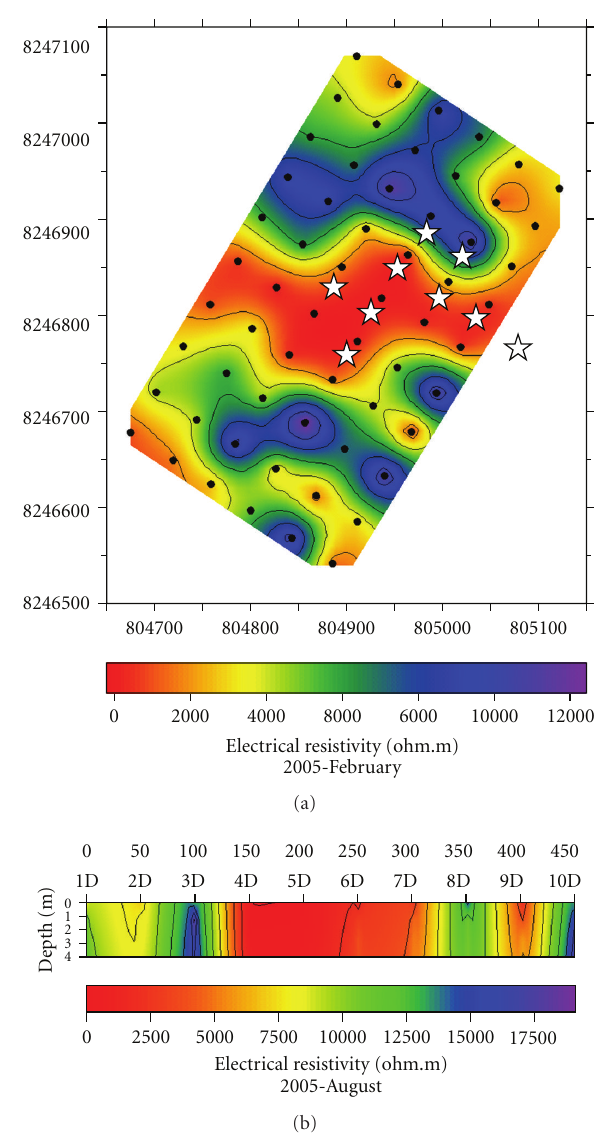
Figure 2: Geophysical surveys in the gravel pit. The central spots correspond to the plume resulting from the chemical sludge in the study area. (a) Horizontal mapping, highlights in white correspond to collection points located in the WTS disposal area. (b) Vertical electric sounding, especially emphasis is given to the area between 150 and 300 meters, where there is the sludge disposal. Graphic scales are di ff erent due to di ff erent times during data